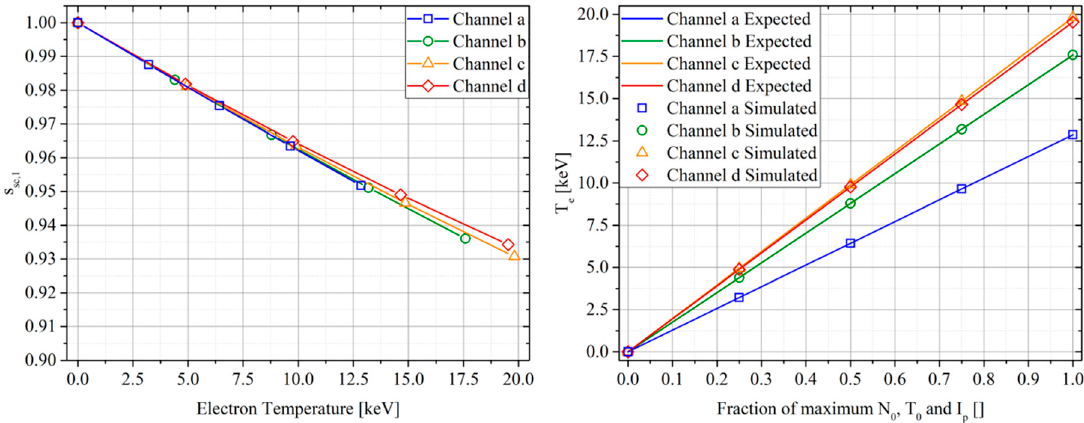
Figure 9. The first component of the reduced scattered Stokes vector as a function of the electron temperature on the four scattering volumes ( left ) and expected vs. simulated electron temperature for each channel at each numerical simulation ( right ).